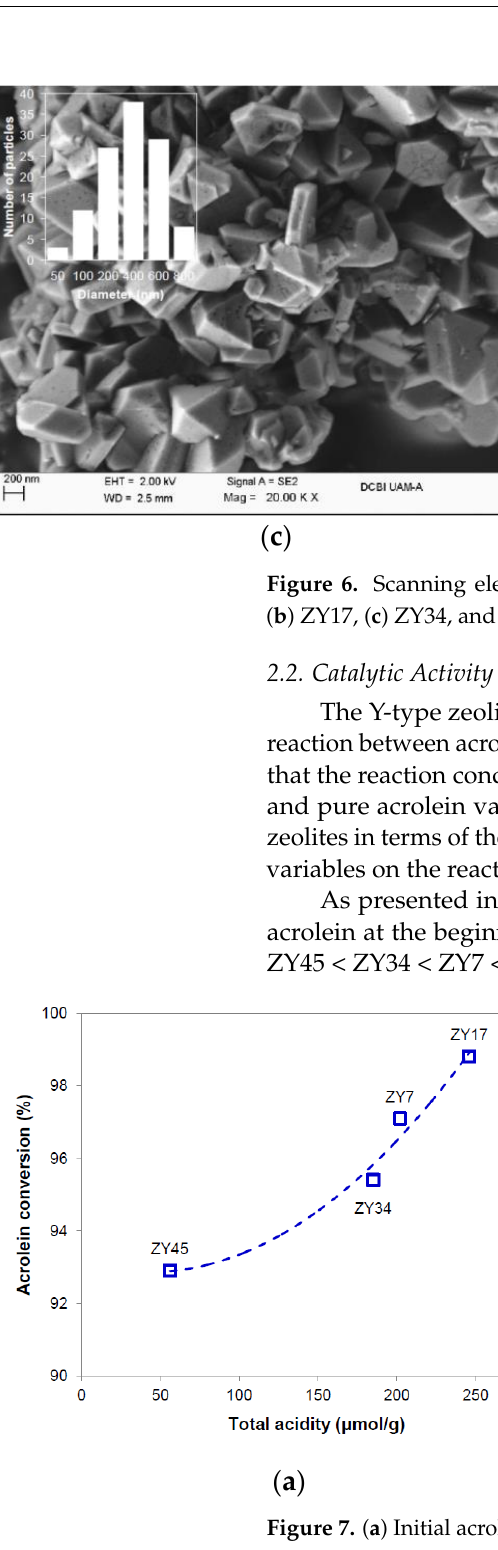
Figure 7. ( a ) Initial acrolein conversion and, ( b ) initial products yield of the reaction between acro- lein and ammonia over the Y ‒ type zeolites. The total yield of pyridine bases = (pyridine + 3-pico- line). Reaction conditions: T = 360 °C, molar ratio NH 3 /acrolein = 2, GHSV = 4994 h − 1 , TOS = 5 min.